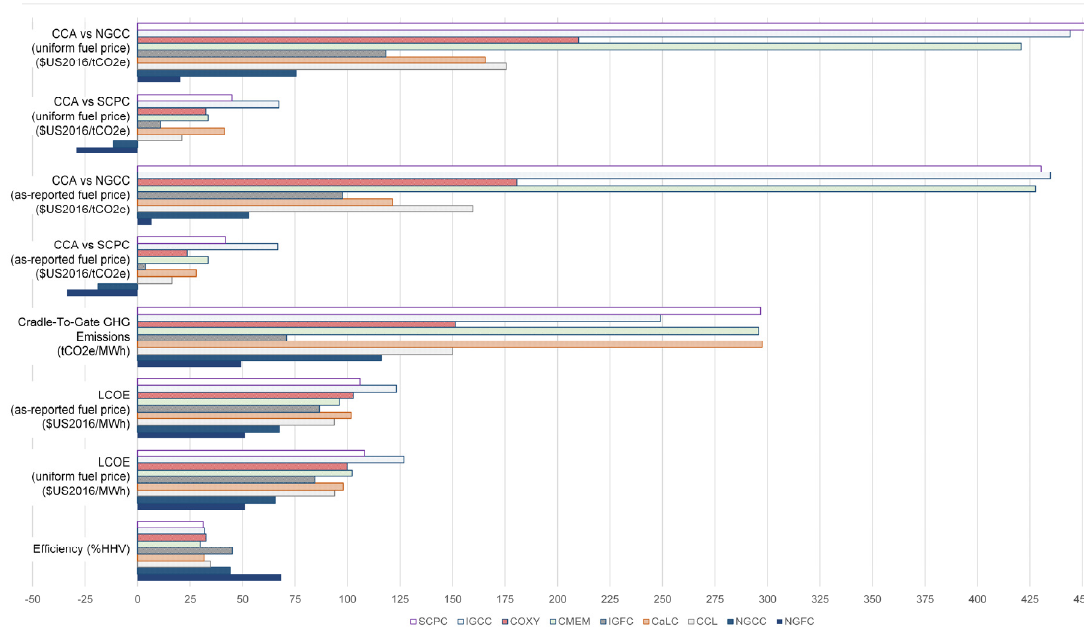
Figure 15. The average values of the key metrics by process category. COXY ‐ 9, COXY ‐ 12, and COXY ‐ 13 were not included (outliers as described in Section 3.2). Note that all plants in the above plot are CCS ‐ enabled.